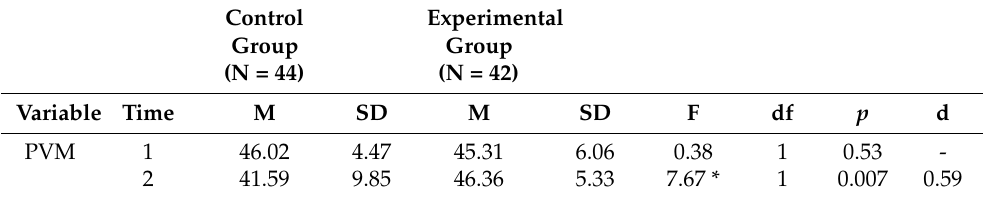
Table 1. ANOVA Results for PVM at Time 1 and Time 2.